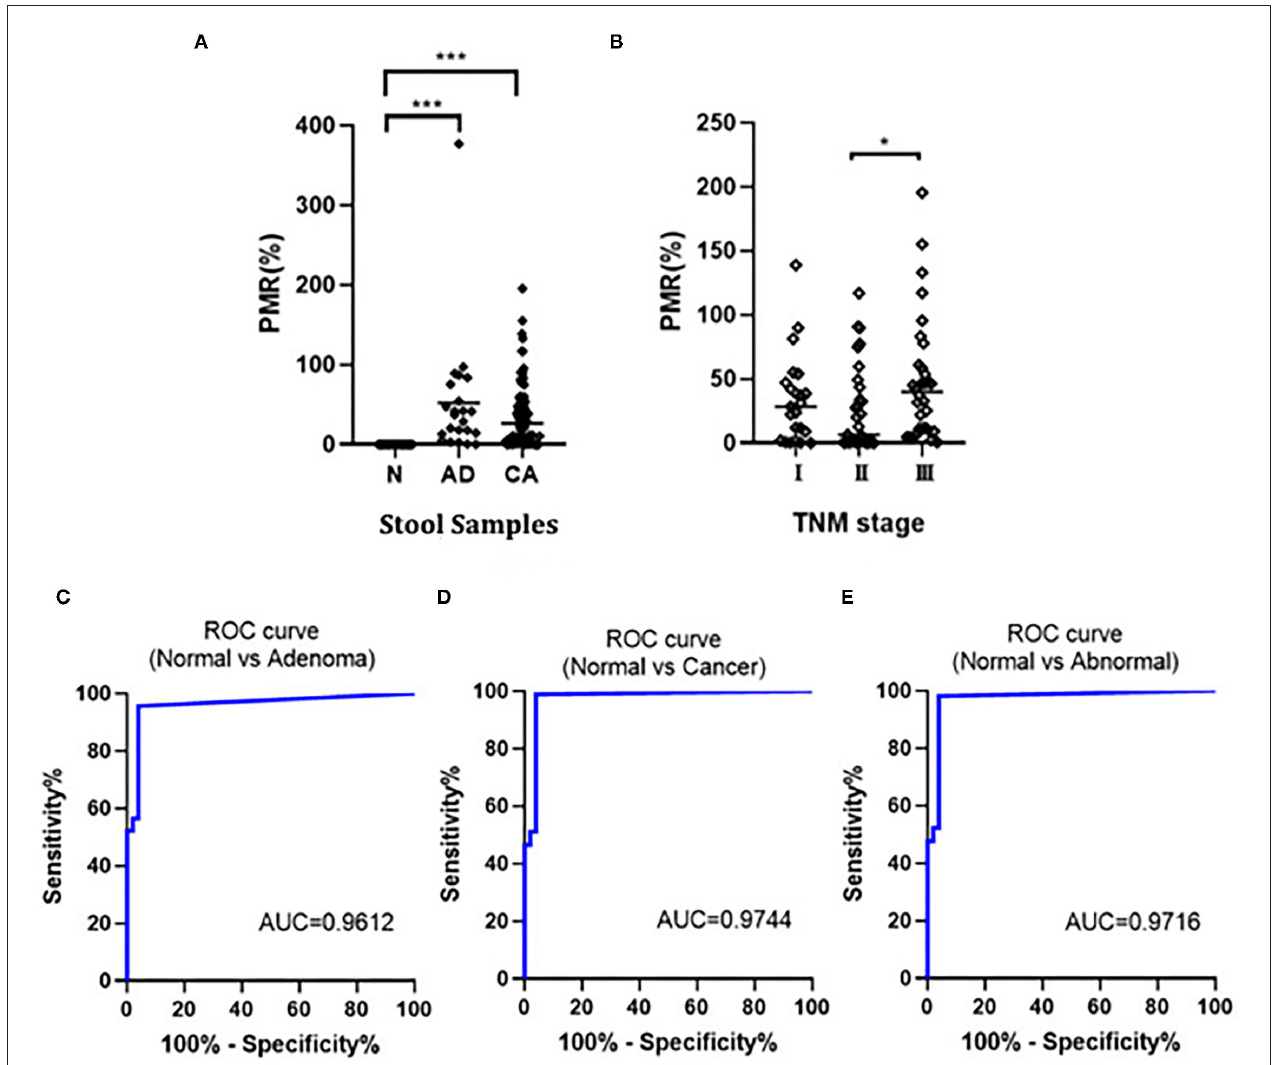
FIGURE 2 | (A) Comparison of SDC2 percentage of methylated reference (PMR) in normal (N), colorectal adenoma (AD), and colorectal cancer (CRC) (CA). *** p < 0.001; (B) Correlation of SDC2 PMR in stool samples with CRC stages. * p < 0.05; (C–E) Receiver operating characteristic (ROC) curves to verify the diagnostic performance of SDC2 gene